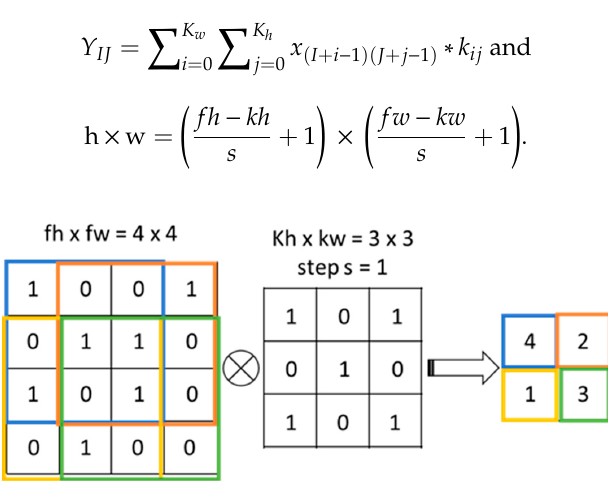
Figure 3. Schematic diagram of convolution kernel operation.